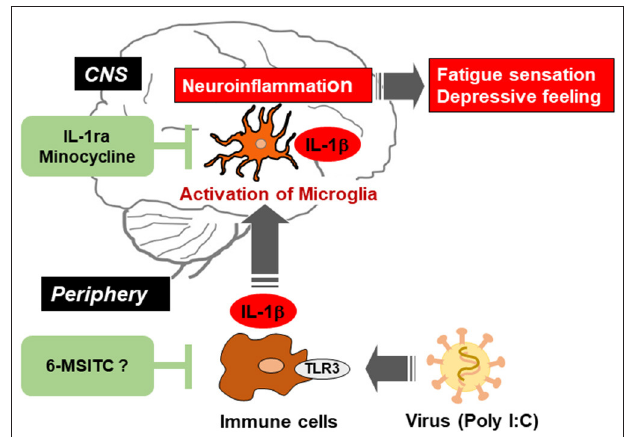
FIGURE 1 | Schematic illustration indicating the viral infection-induced neuroinflammation in the brain via activation of microglia, and the possible therapeutic points by IL-1ra, minocycline, and 6-MSITC. Virus activates toll-like receptor 3 (TLR3) in immune cells and triggers the production of proinflammatory cytokines including IL-1 β . Such cytokines in the periphery induce activation of microglia and production of IL-1 β in the central nervous system (CNS). Neuroinflammation could be alleviated by suppressing immune response in peripheral immune cells and/or microglia in